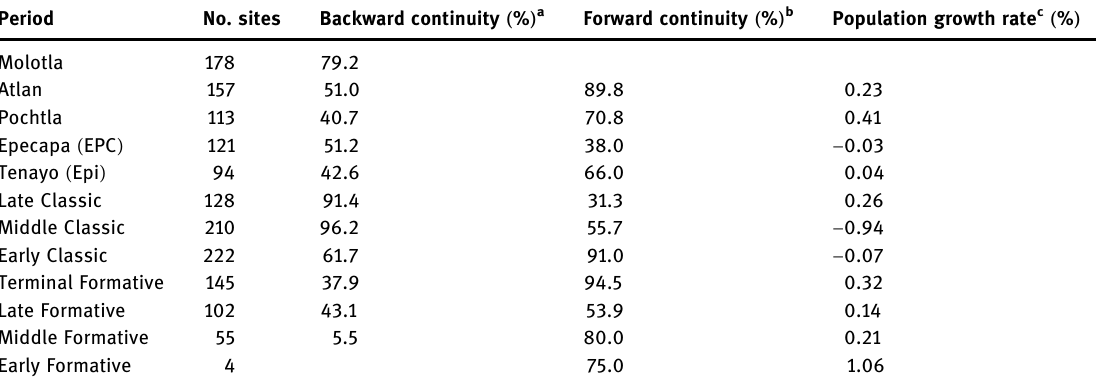
Table 6: Site persistence and annual growth rate